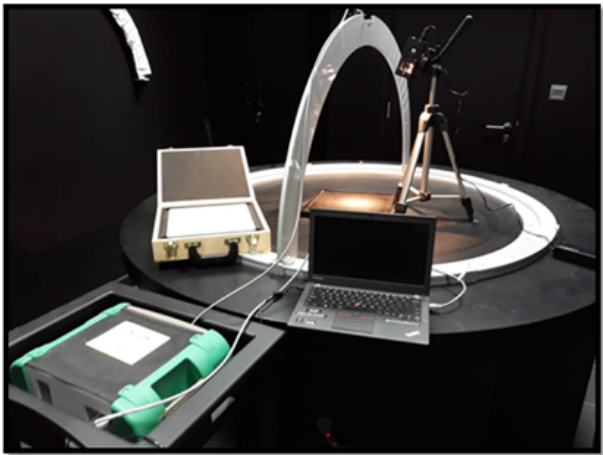
Figure 5. Dark goniometric laboratory for ASD